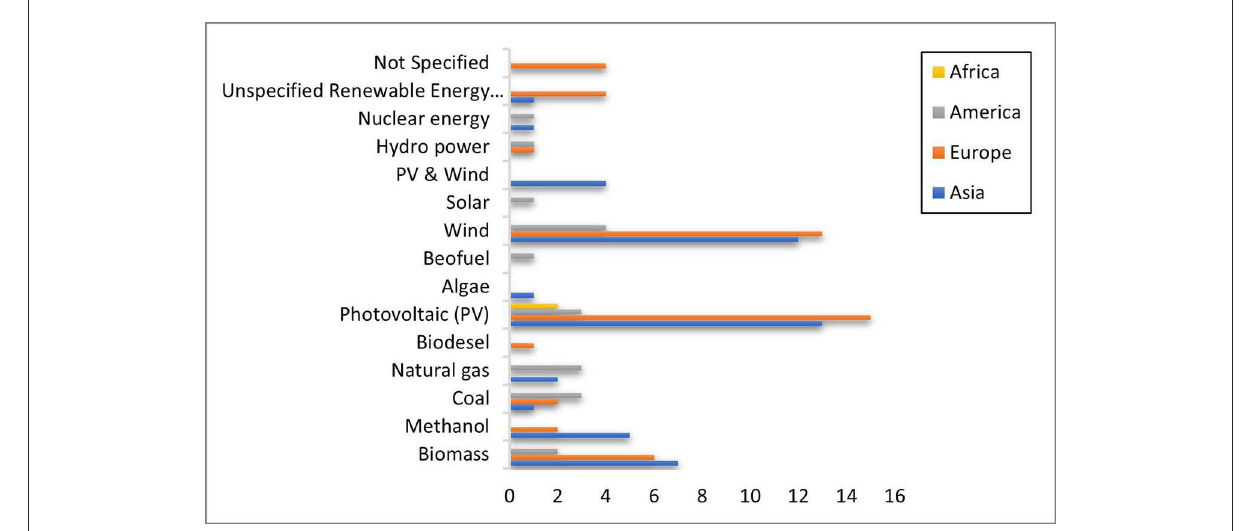
FIGURE3 Geographical primary energy sources.